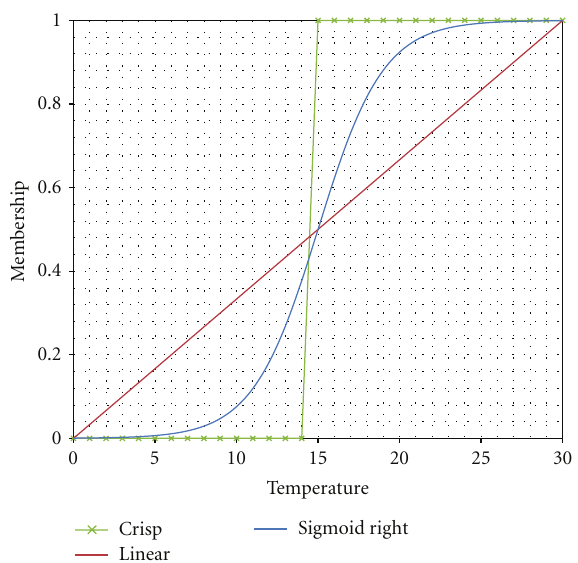
Figure 2: Comparison of membership functions: green-crisp logic approach, red-fuzzy linear, and blue-fuzzy sigmoid